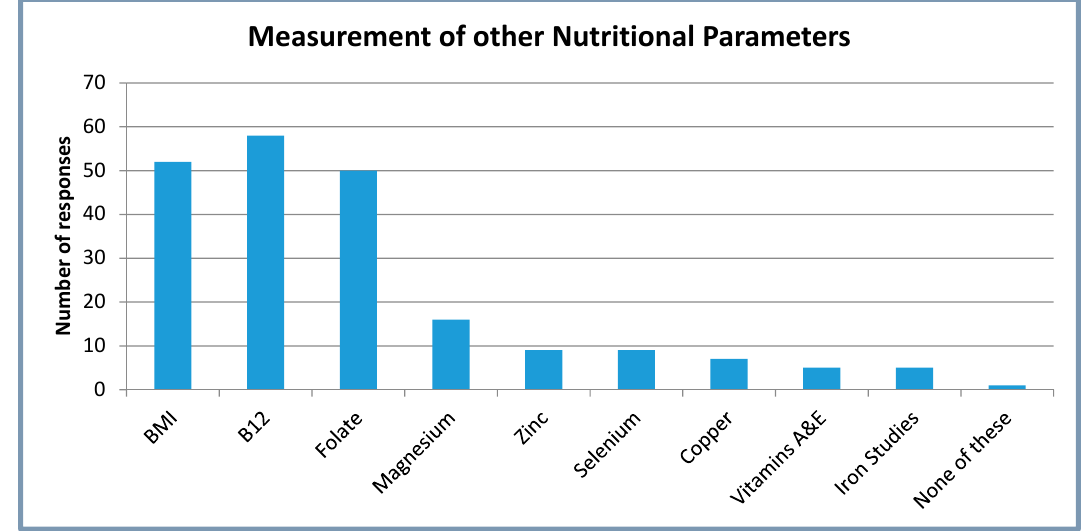
Figure 2. Measurement of other nutritional parameters in Crohn’s disease patients. BMI = body mass index. Iron studies includes ferritin.